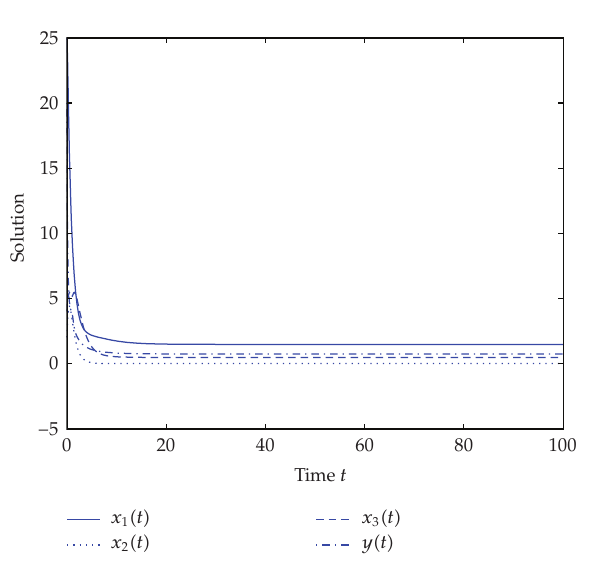
Figure 2: The numerical solution of system (cid:3) 1.4 (cid:4) with α (cid:7) 1 , β (cid:7) 1 , γ (cid:7) 0 . 5 , r 1 (cid:7) 0 . 5 , r 2 (cid:7) 1 , r 3 (cid:7) 1 , r (cid:7) 0 . 5 , a (cid:7) 2 , b (cid:7) 2 , τ (cid:7) 1; (cid:3) φ 1 ,φ 2 ,φ 3 ,ψ (cid:4) (cid:7) (cid:3) 20 , 2 , 6 , 15 (cid:4)